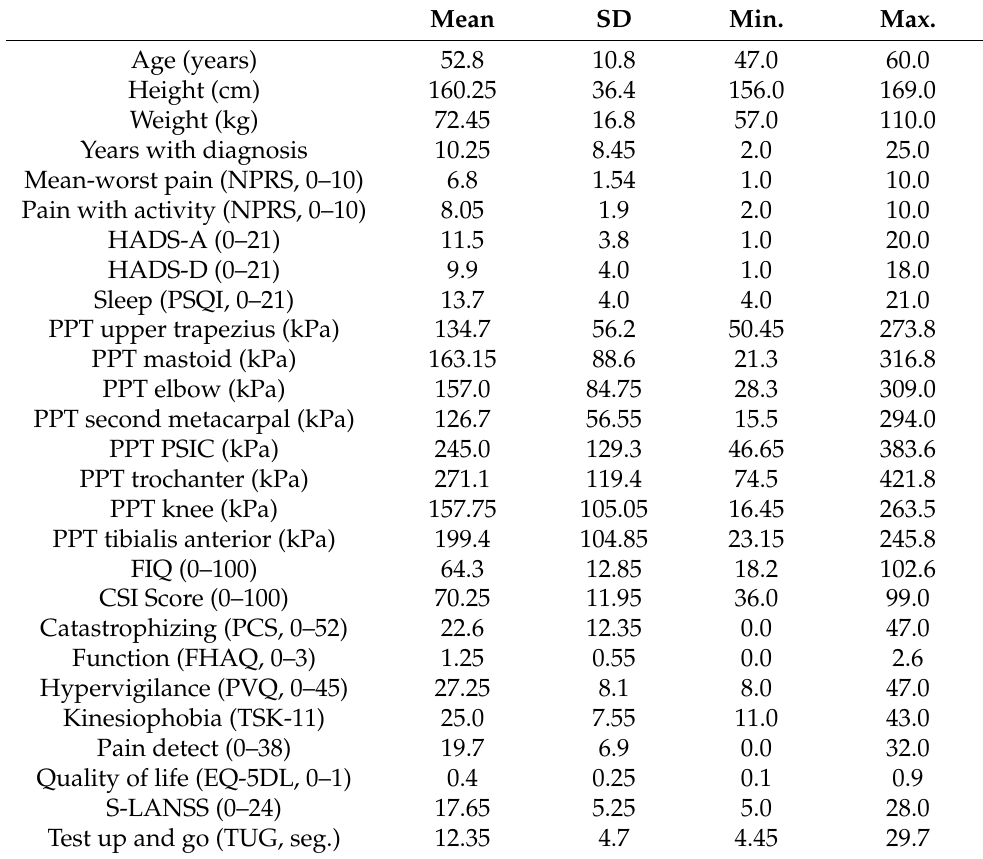
Table 1. Clinical, psychological, psychophysical, health-related, and cognitive data of the sample (n =